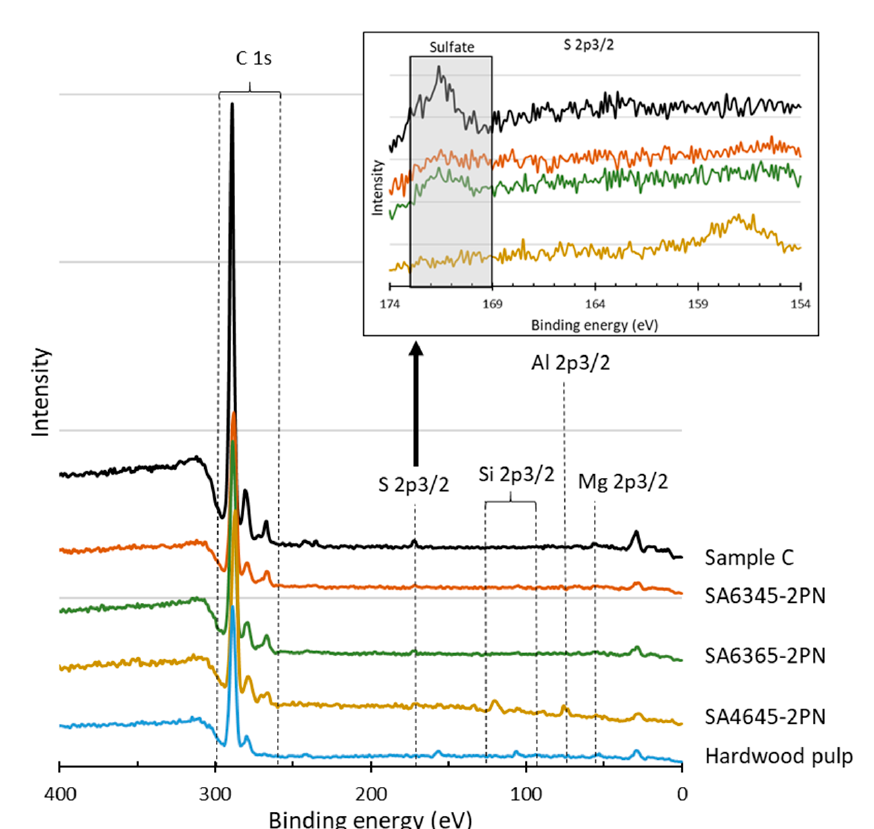
Figure 15. XPS spectrum and magnification of S2p3/2.